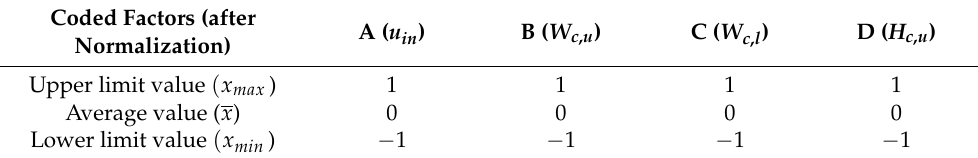
Table 7. Variable size range (after